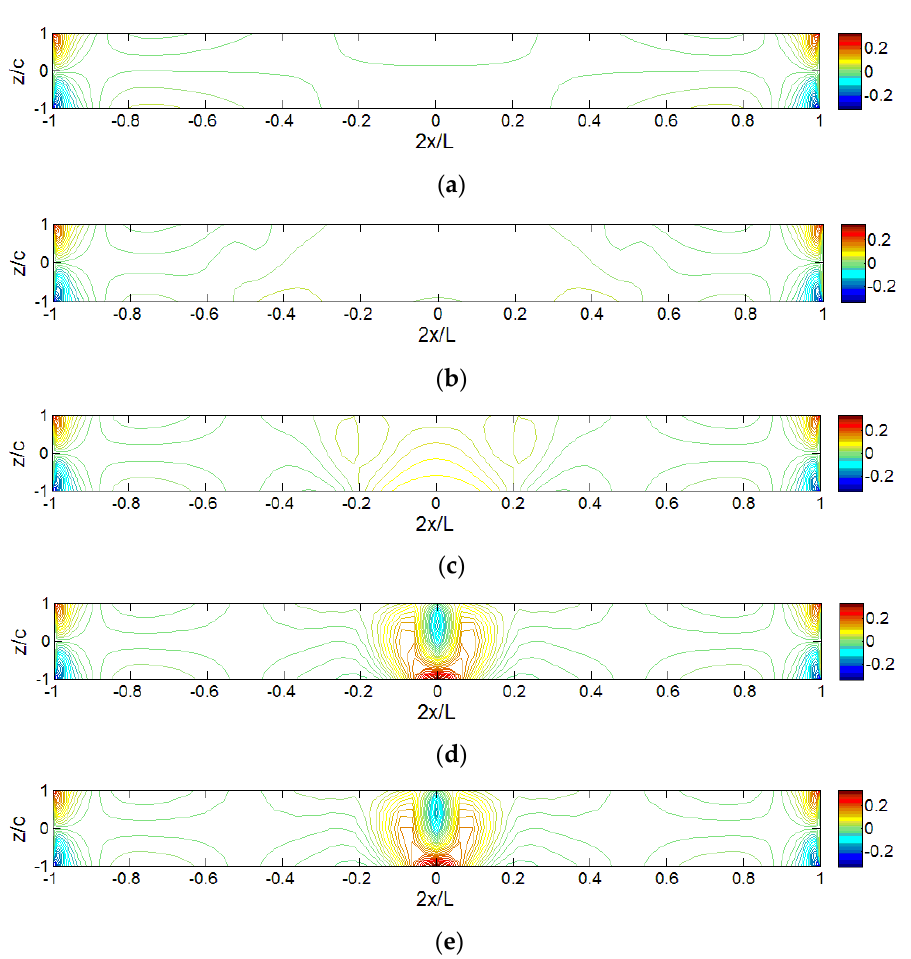
Figure 13. Iso-stress ( σ xx / q ) diagrams for sandwich panels under various locally distributed loads: